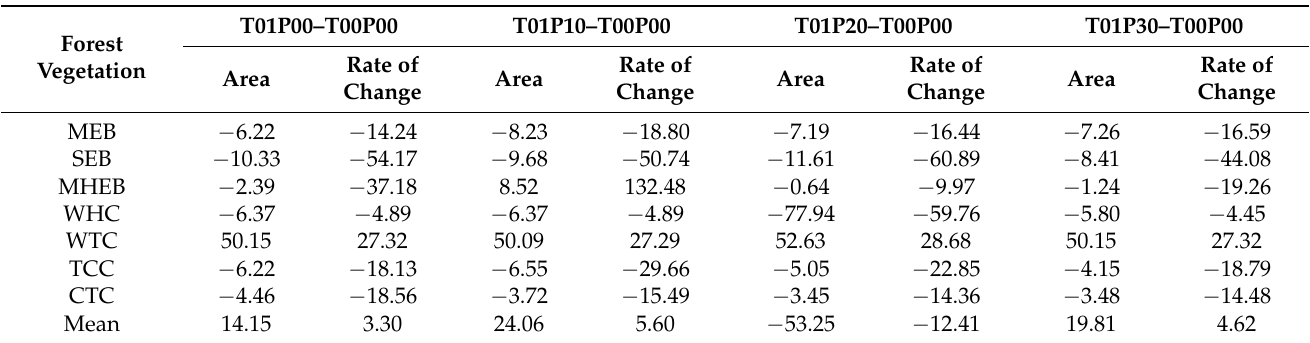
Table 3. Rate of change in the forest distribution area under scenarios with a temperature increase of 1 ◦ C and different decreases in precipitation. Units: Area, × 10 5 ha; Rate of change, %.